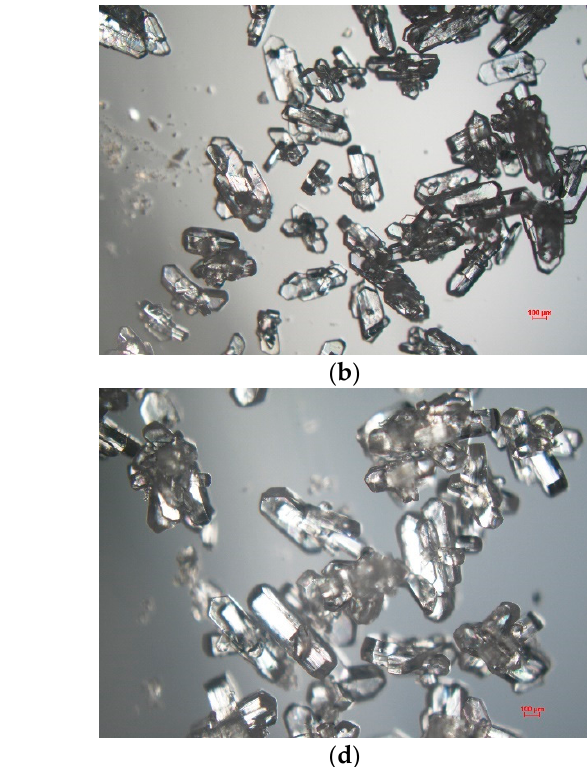
Figure 6. Effects of the starting concentration and temperature profile on agglomeration with a cooling rate of 0.1 °C/min and 1 wt% seed loading; ( a ) 80 mg/g solvent and constant cooling; ( b ) 100 mg/g solvent and constant cooling; ( c ) 140 mg/g solvent and without seed ageing; ( d ) 140 mg/g solvent with seed ageing.